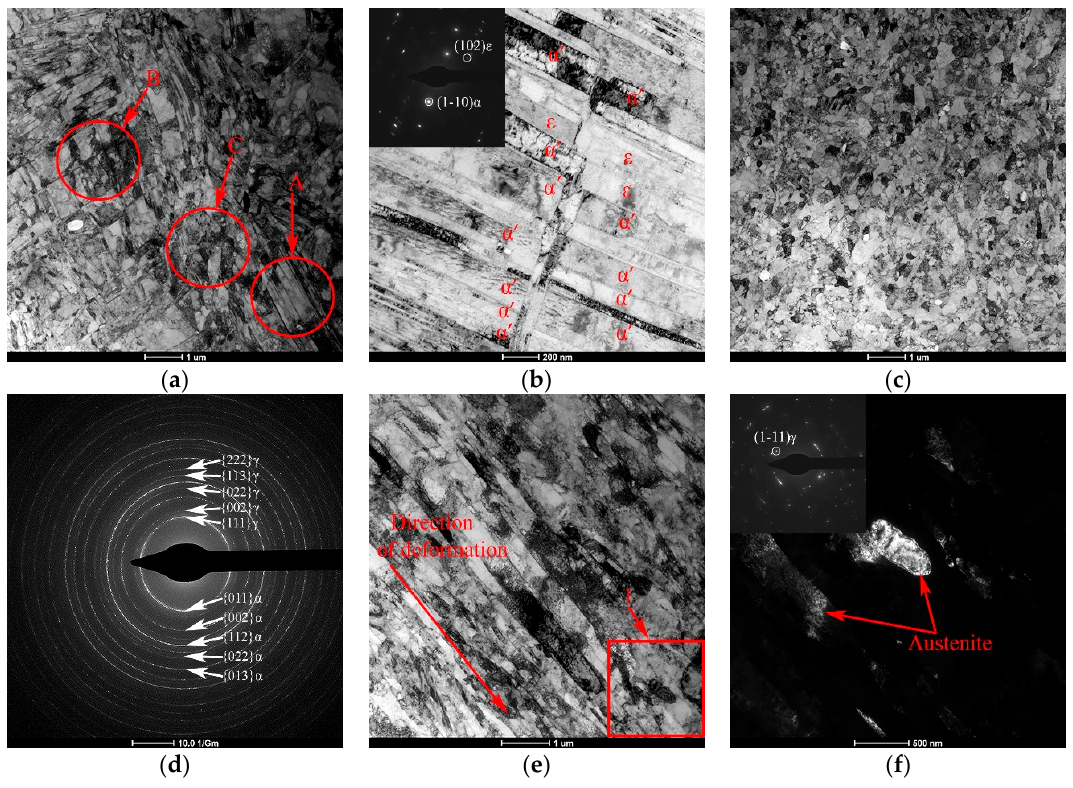
Figure 3. The TEM micrographs of the 321 MASS after deformation with the degrees of e = 1.00 ( a,b ) and e = 2.14 ( c – f ) in the cross ( a – d ) and longitudinal ( e,f ) sections of the rod: ( a,b,c,e ) Bright-field images; ( d ) Microdiffraction image from image c ; ( f ) Dark-field image of section 1 from image e in the reflection (1–11) γ .